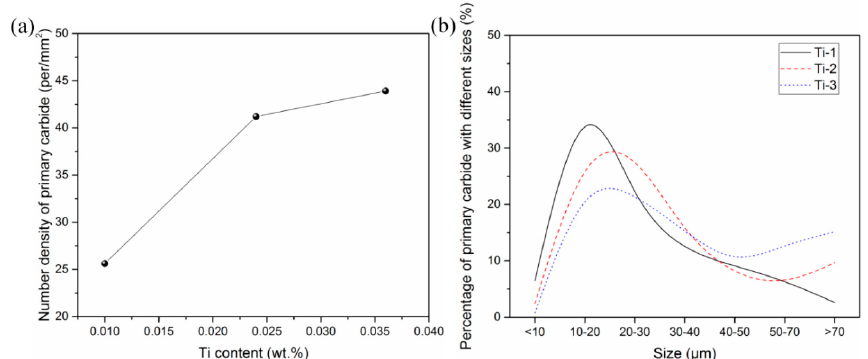
Figure 12. Number density ( a ) and average size ( b ) of the primary carbides in the three-dimensional